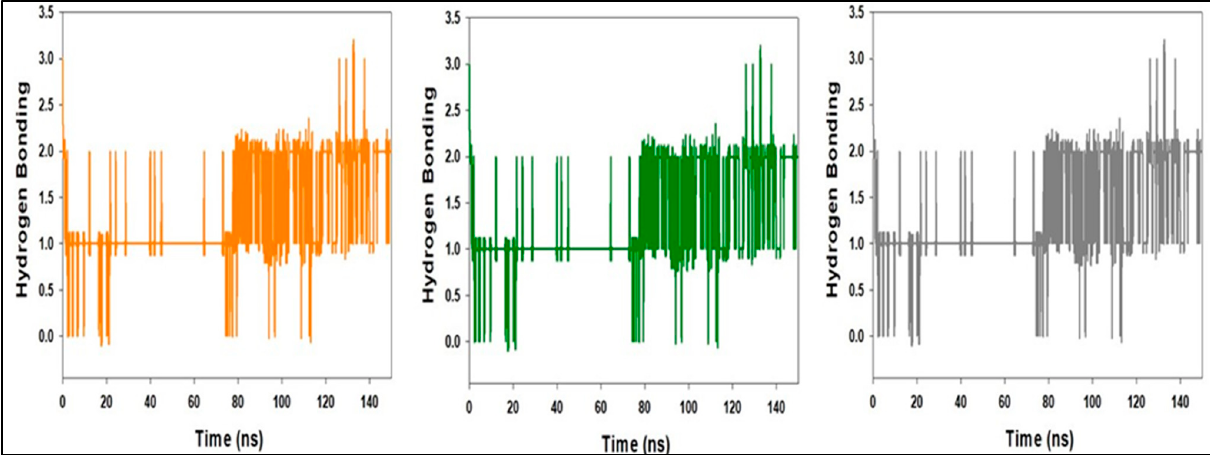
Figure 16. MD simulation trajectory analysis of Hydrogen-bonding (H-bonding) of compound 1 bound with LSD 150 ns time frame in triplicate displayed.